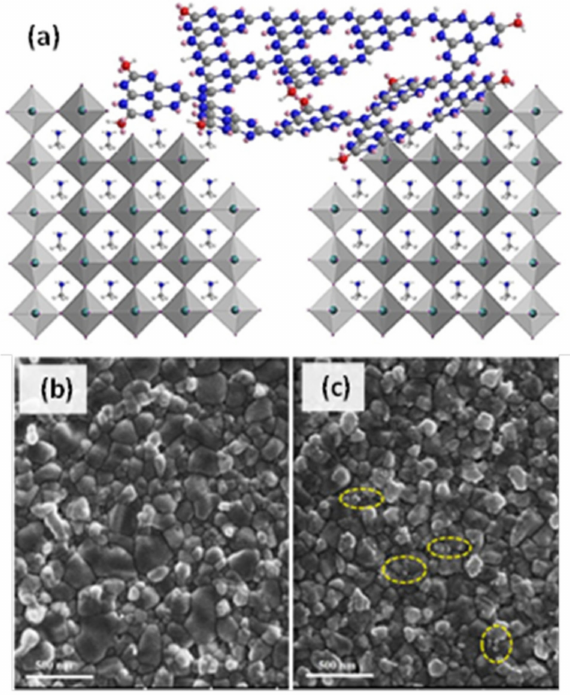
Figure 7. ( a ) Schematic illustration of the self-location process of E-g-C 3 N 4 at MAPbI 3 grain bound- aries by hydrogen bonding interaction. ( b , c ) Top-view FESEM images of MAPbI 3 film and E-g-C 3 N 4 modified MAPbI 3 film, respectively. Reproduced with permission from [97], Copyright 2019,